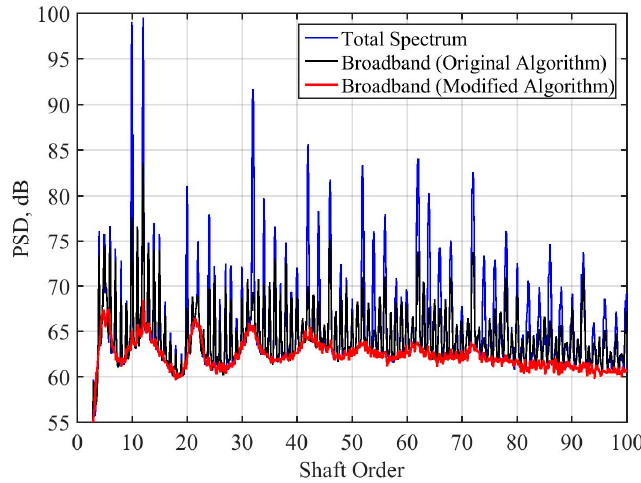
Figure 9. Total and broadband noise spectra from F31/A31 model acoustic data at approach condition.